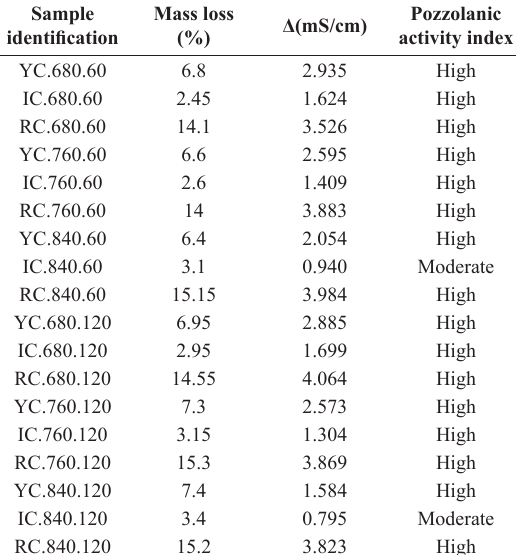
Figure 2. The X-ray diffraction data for the three types of